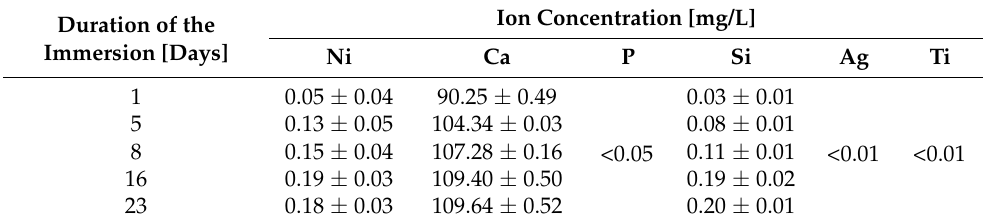
Table 3. Results of the ion concentration in the Ringer solution from the Ag-SiO 2/ TiO 2/ NiTi. Statisti- cal analysis was calculated based on five repetitions and was calculated as the standard deviation.